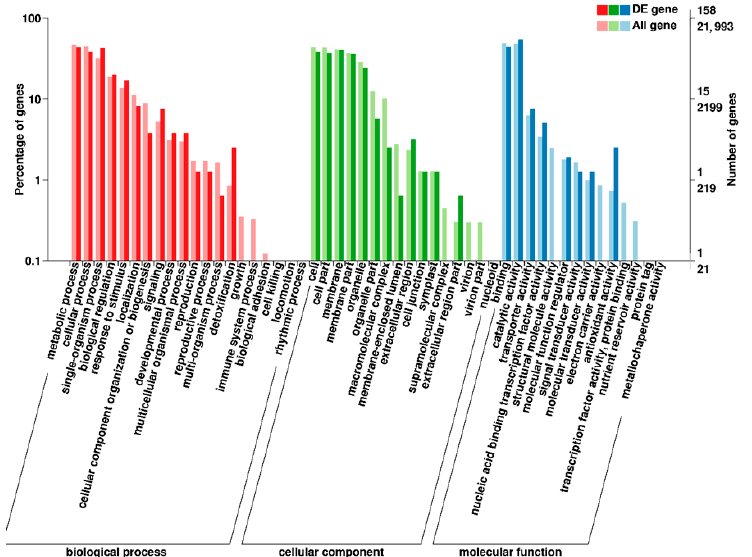
Figure 3. GO enrichment analysis in M versus CK. Notes: The abscissa is the GO classification, the left side of the ordinate is the percentage of gene number, and the right side is the gene number. M stands for mutant ‘ pv-pur ’ and CK stands for